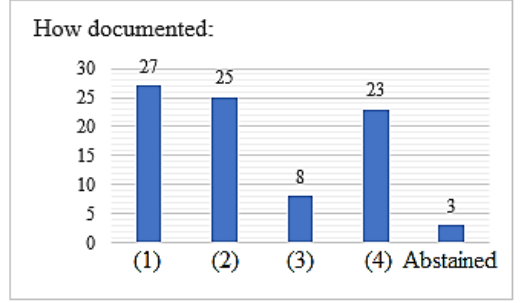
Fig. 4. Requirements documentation.